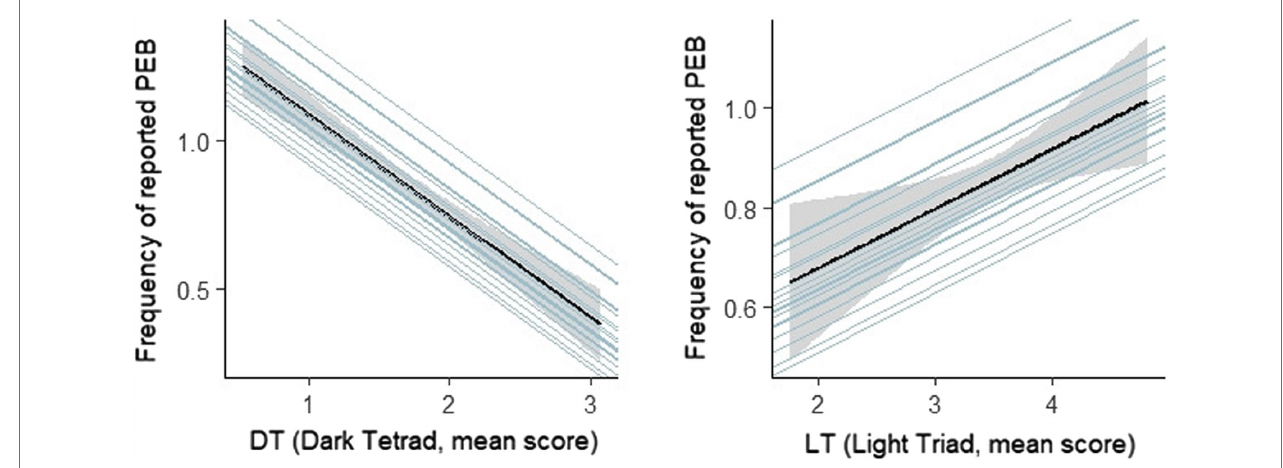
FIGURE 2 | Multilevel models showing the negative relation of the dark tetrad (left) and the light triad’s positive relation (right) with the daily frequency of pro-environmental behavior (PEB). The shaded area displays the CI 95% . The light-blue single lines display individual